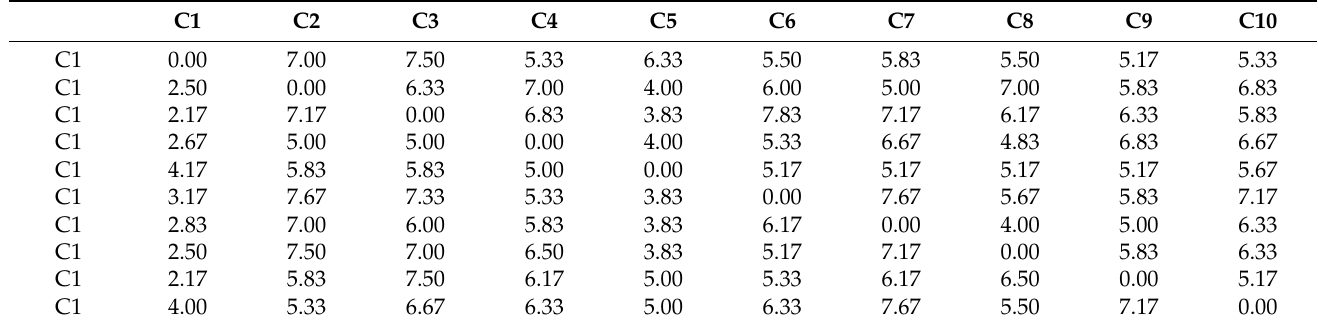
Table 14. Association matrix of big data analysis enablers. (C*C).